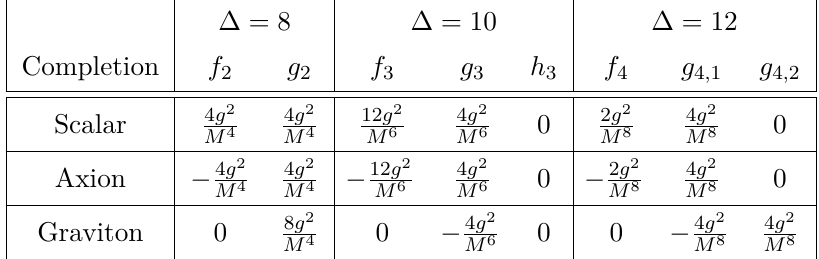
Table 2 . EFT coefficients that result from integrating out various particles of mass M at